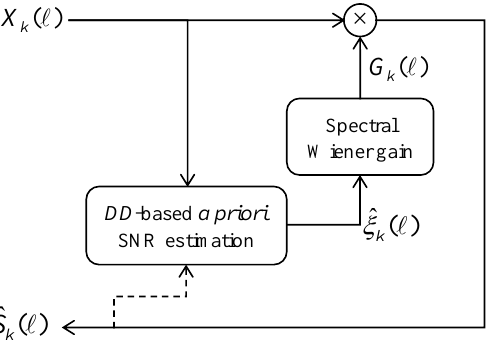
Figure 3. The block diagram of a conventional Wiener filter based on decision-directed (DD) a priori signal-to-noise ratio (SNR) estimation.